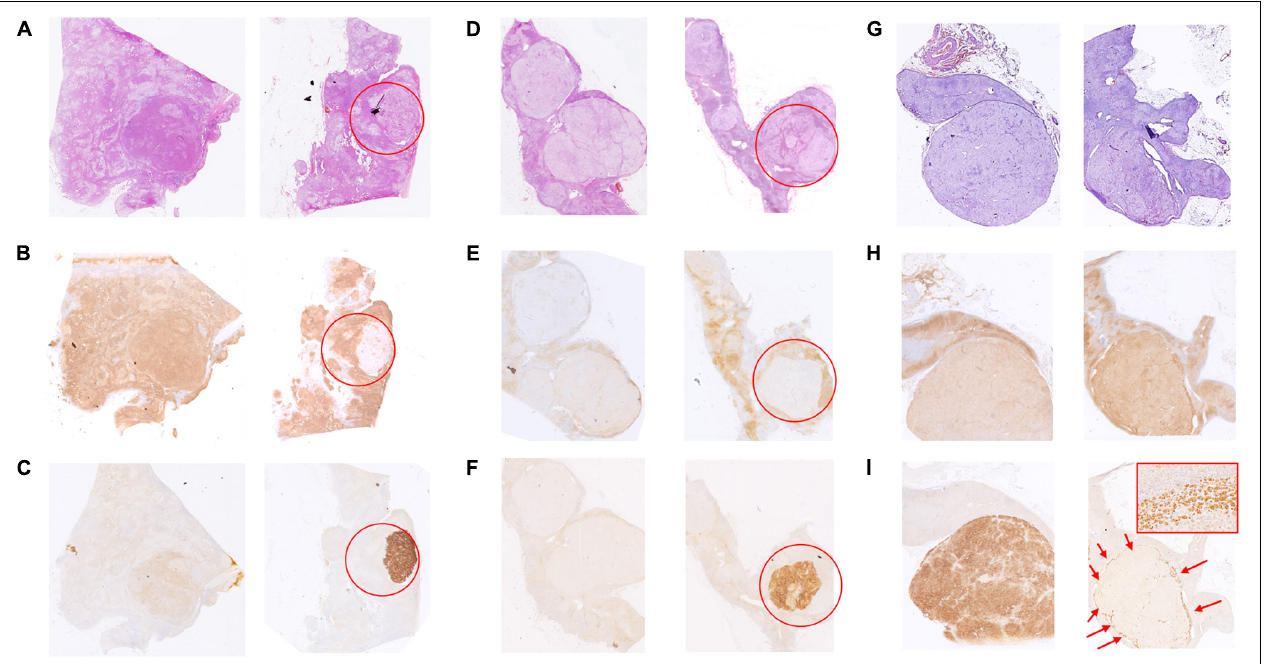
FIGURE 3 | Hematoxylin and eosin (H&E) and immunohistochemical staining of CYP11B1 and CYP11B2 in cases 17, 6, and 18. In case 17, one obscure nodular mainly with acidophilic cells ( A , left), the other one with a mixture of acidophilic cells and clear cells ( A , right, marked by the red circle). One-third of the nodules are positive for CYP11B2 ( C , marked by the red circle) and weak positive for CYP11B1, moderate expression for CYP11B1 in the rest zone of the nodule ( B , marked by red circle). In case 6, one of 4 clear cell nodules (0.8 cm in diameter) ( D , marked by the red circle), focal CYP11B2-positive and CYP11B1-negative area by 4 mm × 3 mm (E,F) , moderate expression of CYP11B1 in the rest of nodule (E) . In case 18, 2 clear cell-dominant nodules ( G , left and right), the rare annular-pattern of CYP11B2 expression on the periphery of the smaller nodule ( I , indicated by red arrows, 200 × magnification for insert), moderate expression of CYP11B1 ( H , right), strong expression of CYP11B2 ( I , left), and slight expression of CYP11B1 ( H , left) in the bigger